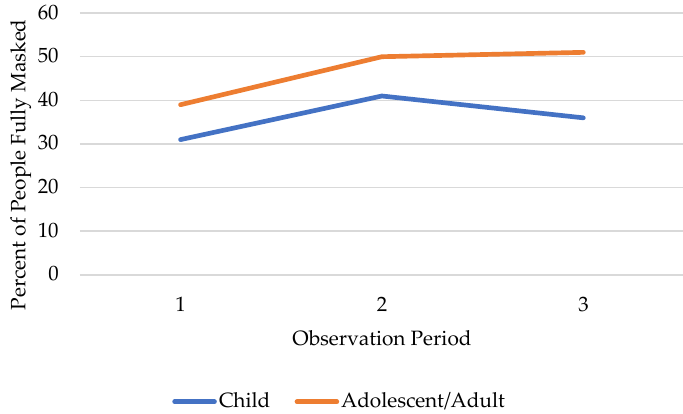
Figure 1. Masking trends over time in children and adolescents/adults. Overall masking behavior differences by race/ethnicity are illustrated in Figure 2. The highest prevalence of full masking (55.6%) was in racial groups that were neither White, Black, nor Hispanic, while the lowest (39.3%) was among Whites. The highest prevalence of partial masking was among Blacks (48.2%), while the lowest was among Whites (6.9%). When full masking was analyzed across the three observation periods, all race/ethnicity groups increased the rate of full masking from the first to the second observation period. A divergent pattern was seen from the second to the third observation period, where White, Black and Hispanic groups decreased full-masking rates, while the Other group further increased the rate of full masking.